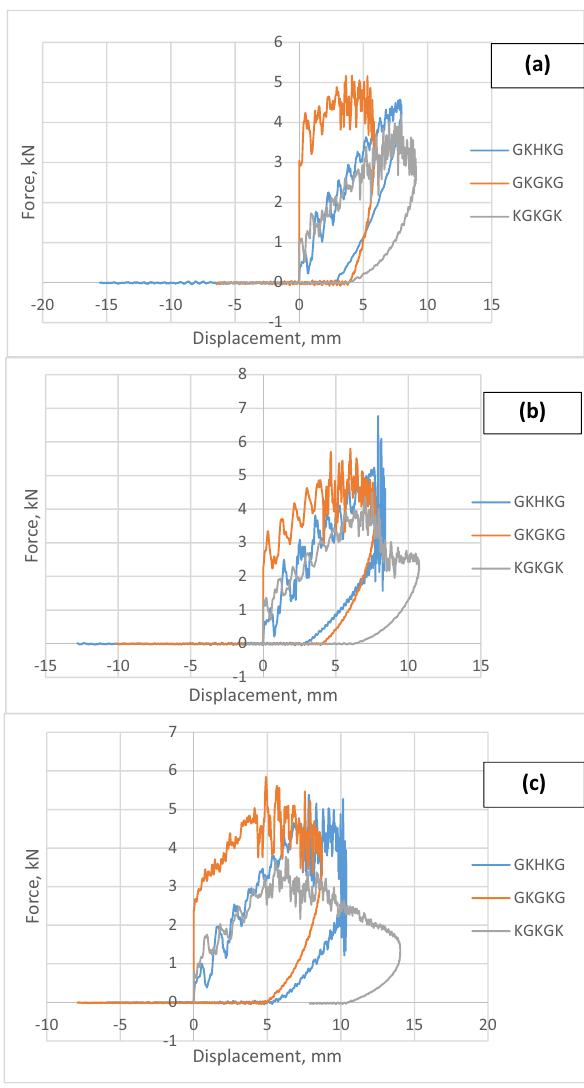
Figure 8: Force vs displacement of all types for di ff erent impact energy levels. ( a ) 20 J, ( b ) 25 J, and ( c ) 30